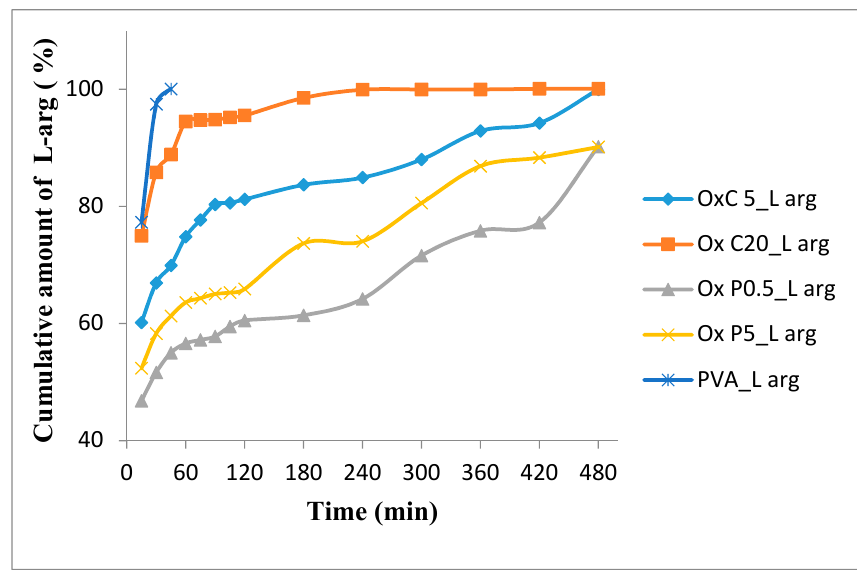
Figure 10. The most relevant curves showing the in vitro profile of L-arginine from the investigated